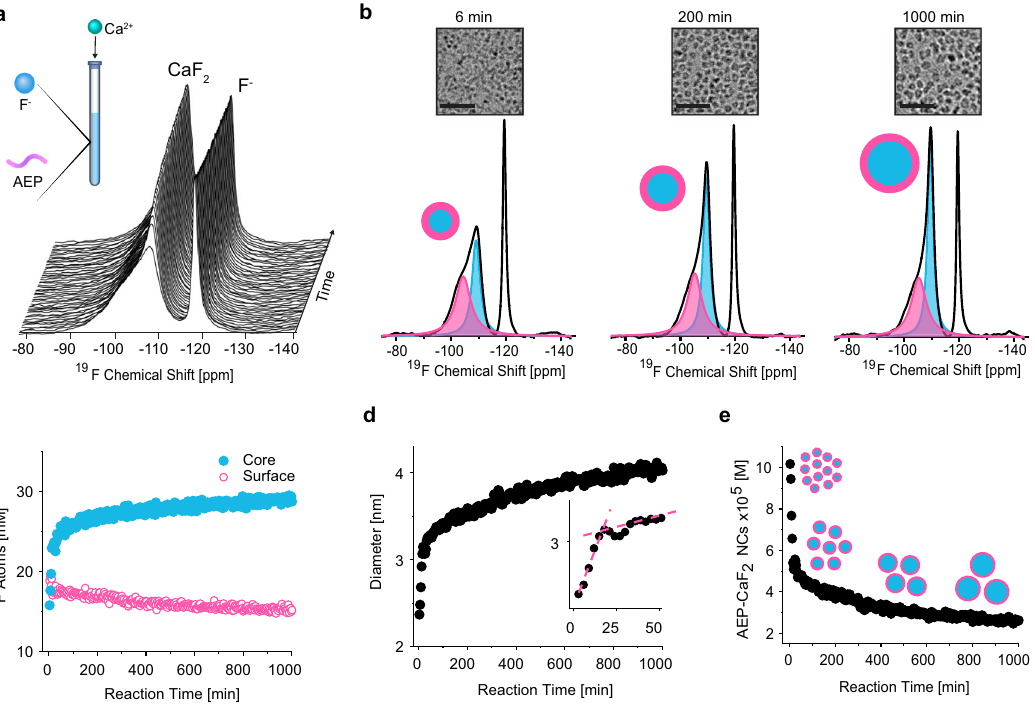
Fig. 2 Real-Time, high-resolution 19 F-NMR of CaF 2 NC evolution in water. a Stack plot of real-time 19 F NMR spectra after the addition of Ca + 2 to the aqueous solution of AEP and F - anions. Shown spectra were taken every 30 min (experimental temporal resolution, 3 min). b Deconvoluted 19 F-NMR spectra from three different time points during the reaction (6, 200, and 1000 min), showing the signals of 19 F atoms on the surface (pink) and in the core (blue). Upper images are the correspondent cryo-TEM images of AEP-CaF 2 NCs. c Quantitative plot of the 19 F-NMR signals of the fl uoride atoms in the core and on the surface of the formed NCs, calculated from the convoluted peaks ’ areas at − 109 ppm and − 105 ppm, respectively. d Evolution of the AEP- CaF 2 NC diameter in water throughout the reaction process. Diameters were derived from Eq. (1). Inset shows the fi rst 50 min of the reaction; dashed lines are a visual guide for the two respective slopes of the NC evolution stages. e The concentration of AEP-CaF 2 NCs (multiply by 10 5 in the graph) in the reaction solution as a function of reaction time, calculated from Supplementary Equation